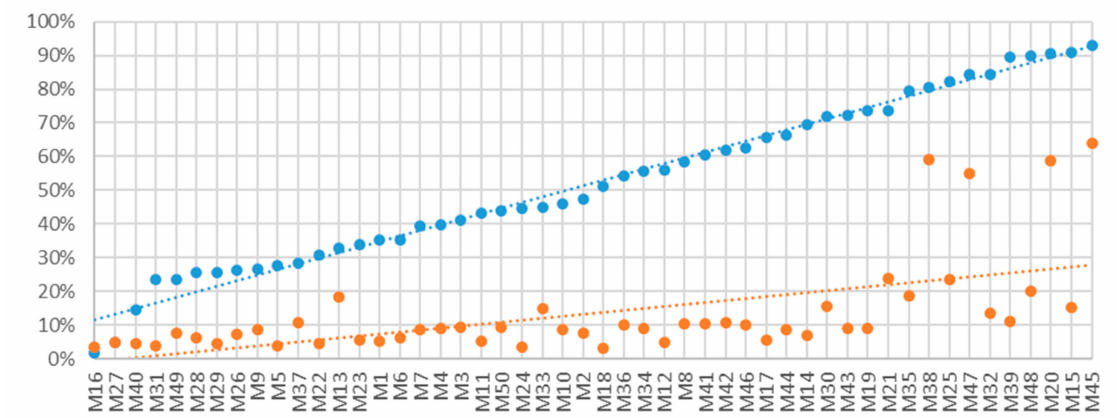
Figure 10. Graphic map load of maps from the Ref-Set obtained during user testing (L UP , marked blue) and measured by IC2 metric (L IC2 , marked orange) sorted in ascending order by L UP , dotted lines indicate trends.